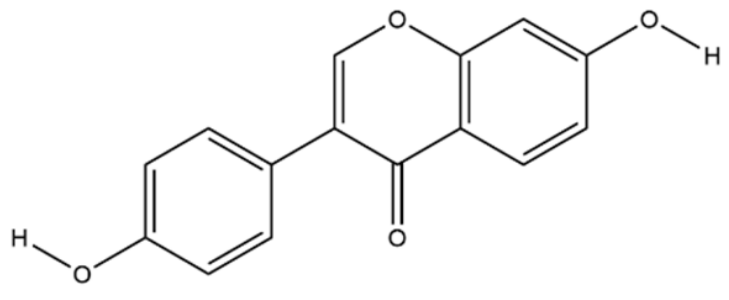
Figure 1. Structure of